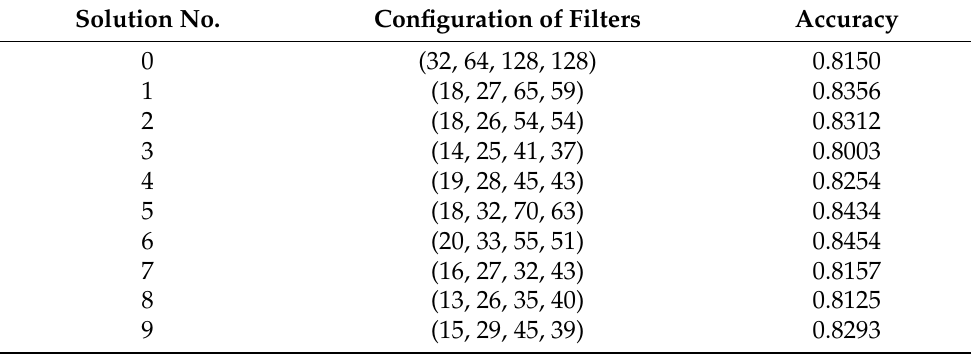
Table 10. Pruning results of EMOFP for cat and dog classification. Solution No. 0 means the information of original CNN